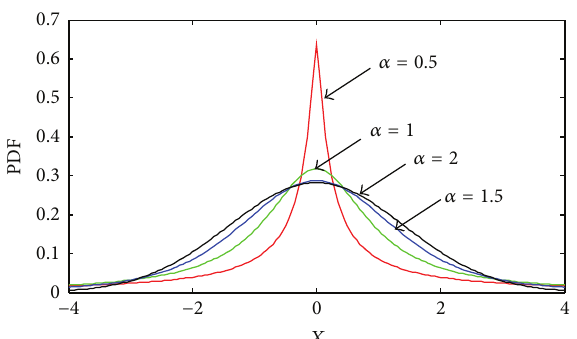
positive and negative impulses while preserving other